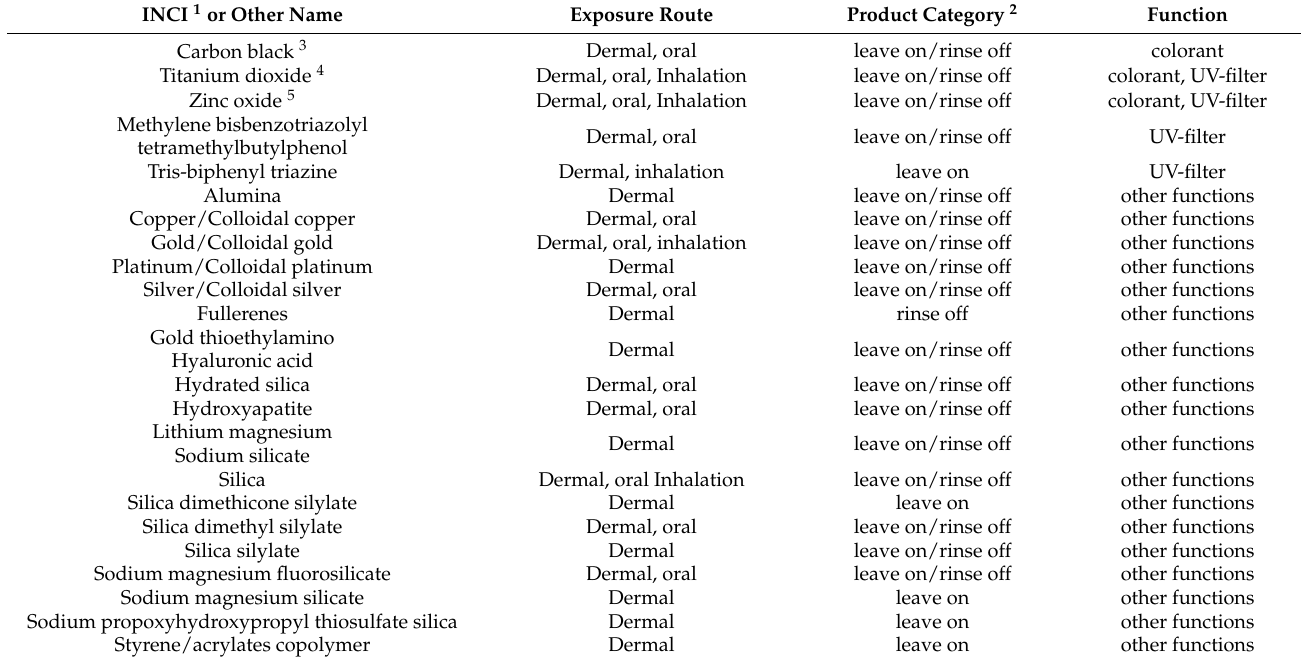
Table 5. Nanomaterials presented in nanocatalogue by European Commission [28].